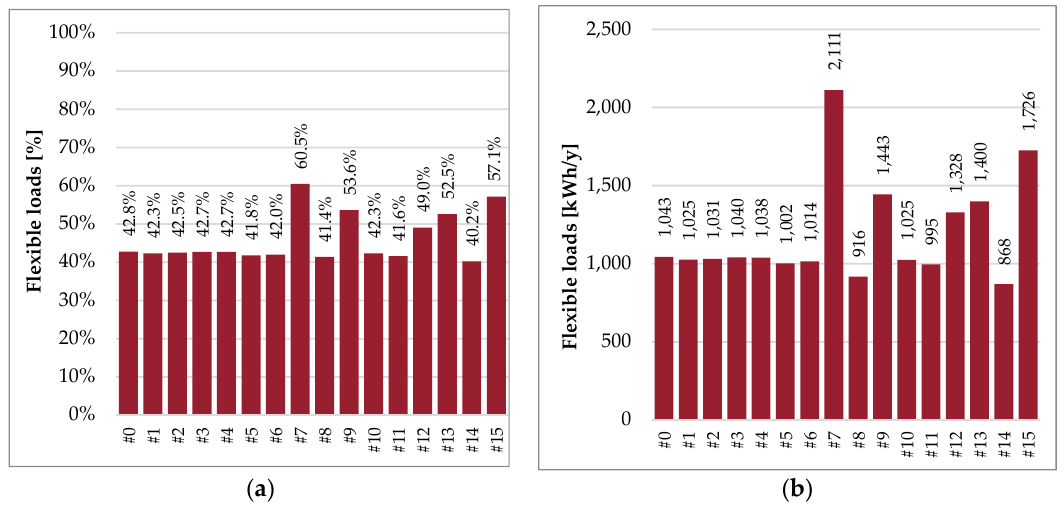
Figure 13. Flexible loads after renovation interventions. ( a ) Percentage values; ( b ) absolute values.